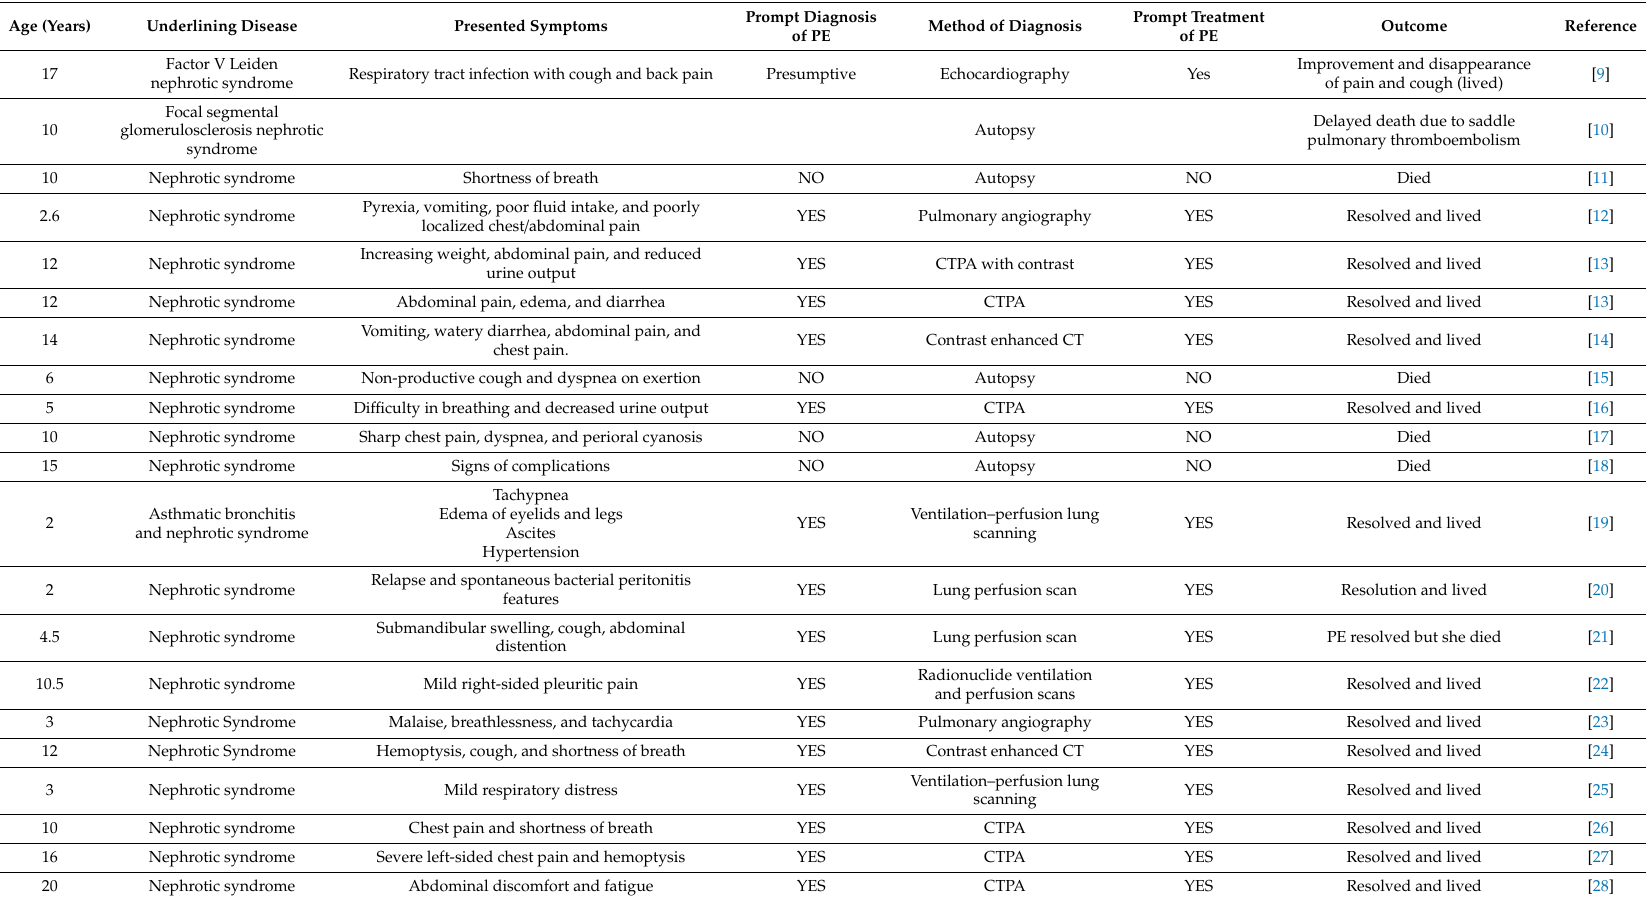
Table 2. Summary of previous case reports involving patients who experienced pulmonary